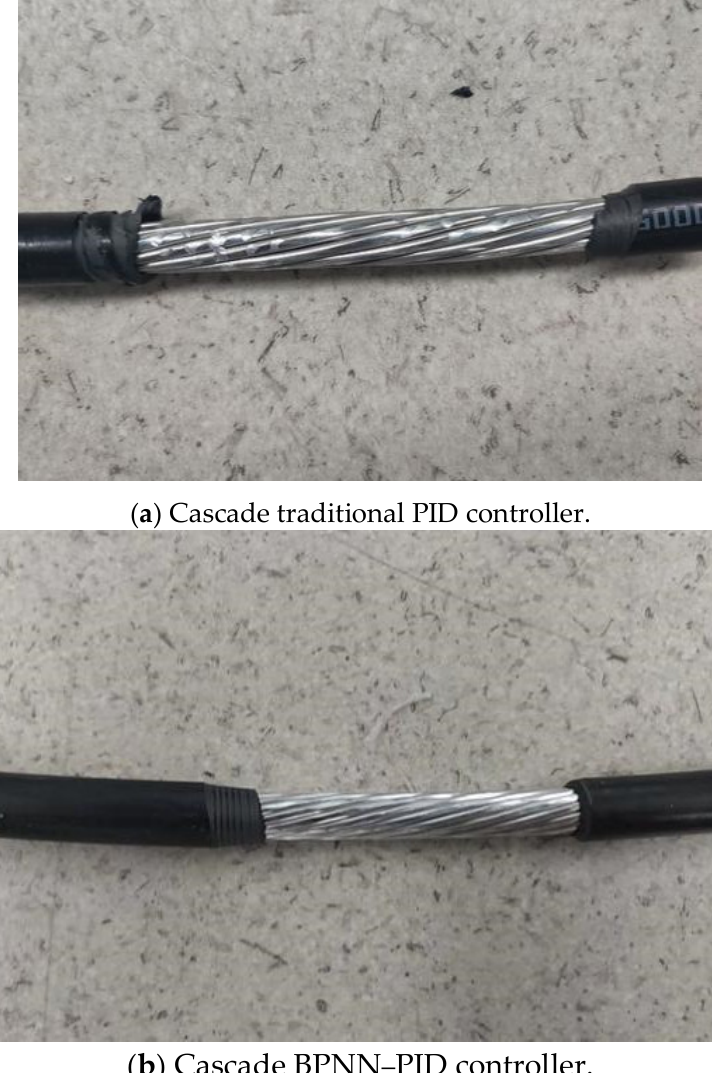
Figure 9. Stripped appearance using different controllers. The experimental test of the robot sampled the motor speed of each mechanism. The expected speed of the rotating mechanism of the main motor was set at 28.6 rpm. Figure 10 shows the response curve of the cascaded traditional PID algorithm and the cascaded BPNN–PID method. It can be seen from the figure that the speed response curve range of the cascade PID output was [15, 40] rpm, and the maximum error floating rate was 47.5%; in contrast, the speed response curve range of the cascade BPNN–PID output was [23, 33] rpm, and the maximum error floating rate was 19.5%. This further proves the superior performance and strong robustness of the BPNN adjustment